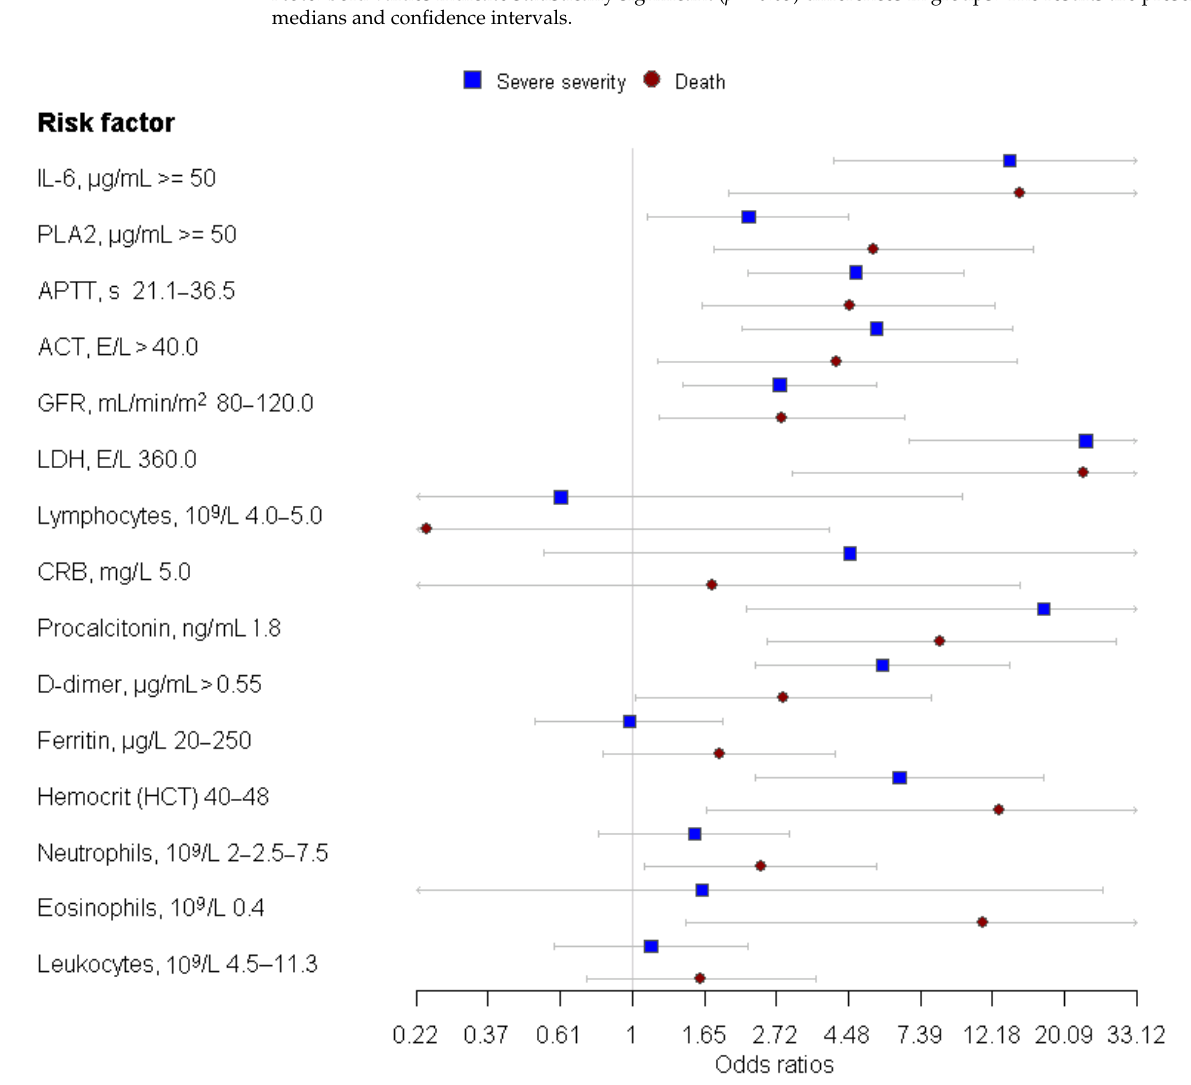
Figure 4. Odd ratio (OR) for patients with a severe COVID-19 infection and death .